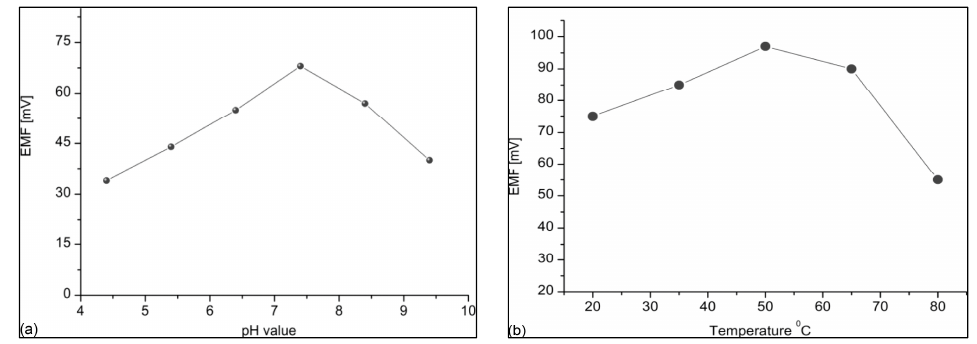
Figure 8. ( a , b ) Impact of different pH and temperature values on the response curves of zinc ion sensor [48].